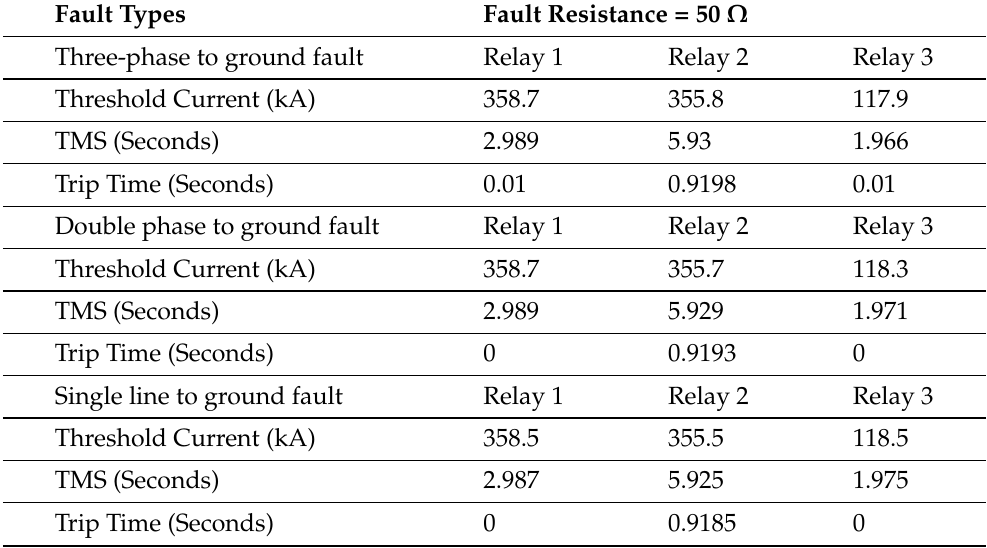
Table 5. Threshold current at fault resistance of 50 Ω